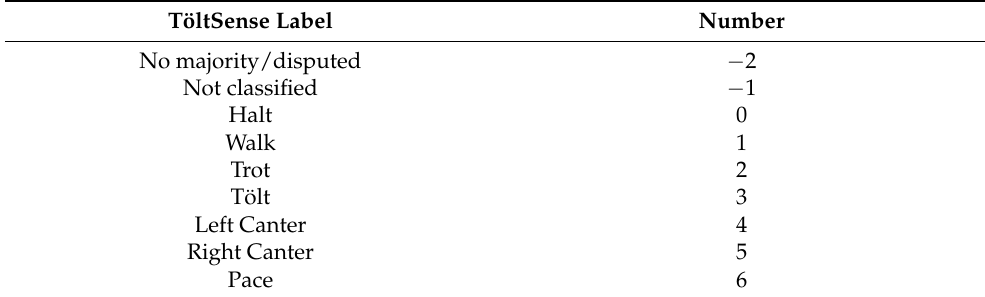
Figure 5. Plot of speed vs. time colour coded by gait from the TöltSense session overview screen. Table 1. Gait labels used by judges. The table shows the gait labels from the TöltSense system that the judges used to label the video